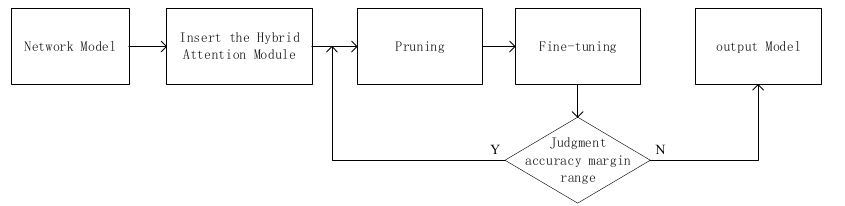
Figure 4. Flow chart of the pruning process guided by the hybrid attention mechanism. The Algorithm 1 flow is shown below. Algorithm 1. CCPCSA Algorithm